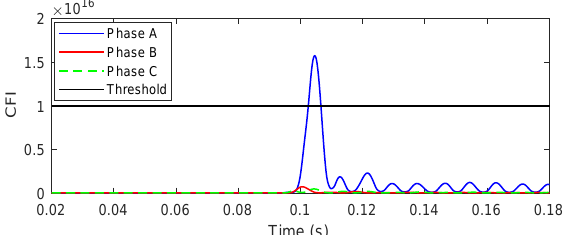
Figure 10. Combined fault index with AG fault on node 652 of test system.